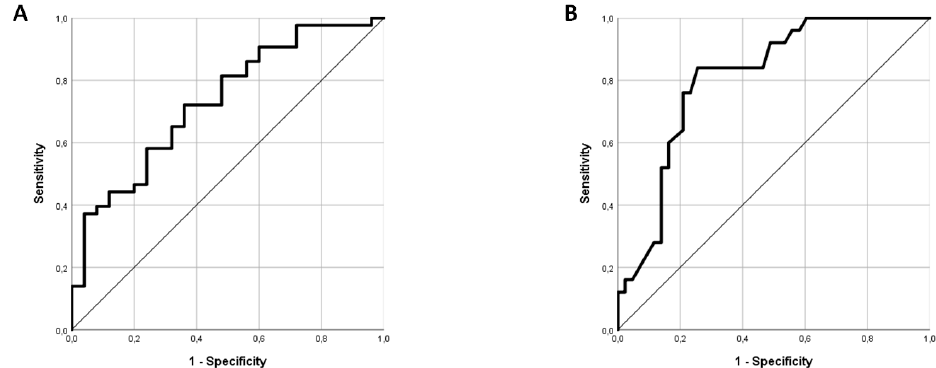
Figure 2. ROC analysis of L-arginine/SDMA ratio (A) and CIMT (B) as distinguishing markers between AF and ESUS patients. a: AUC: 0.732; (95% CI: 0.610–0.854; p = 0.002); b: AUC: 0.807 (95% CI: 0.704–0.910; p < 0.001).